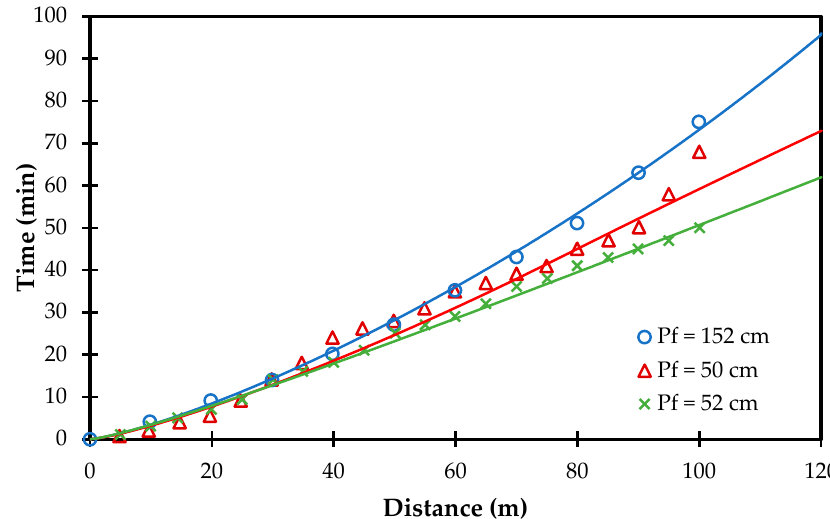
Figure 4. Evolution of the advance front in the border irrigation with shallow water table.